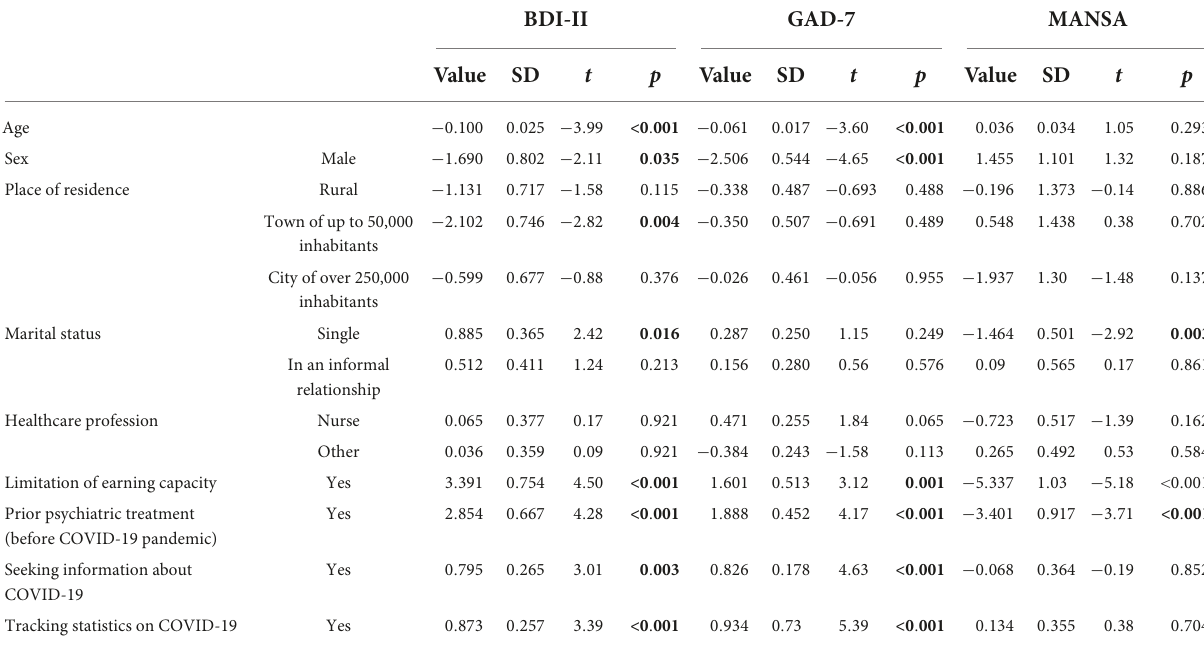
TABLE 5 Summary of relationships between sociodemographic variables and the mean values of the BDI-II, GAD-7, and MANSA scales based on linear models.